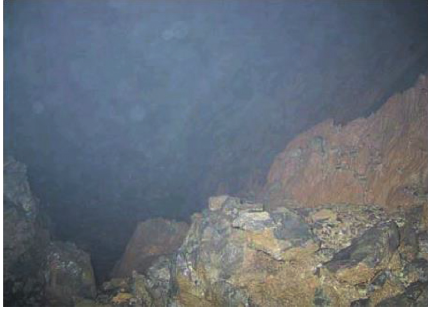
Figure 6: The scene photographs of the inside of the Karst cave.